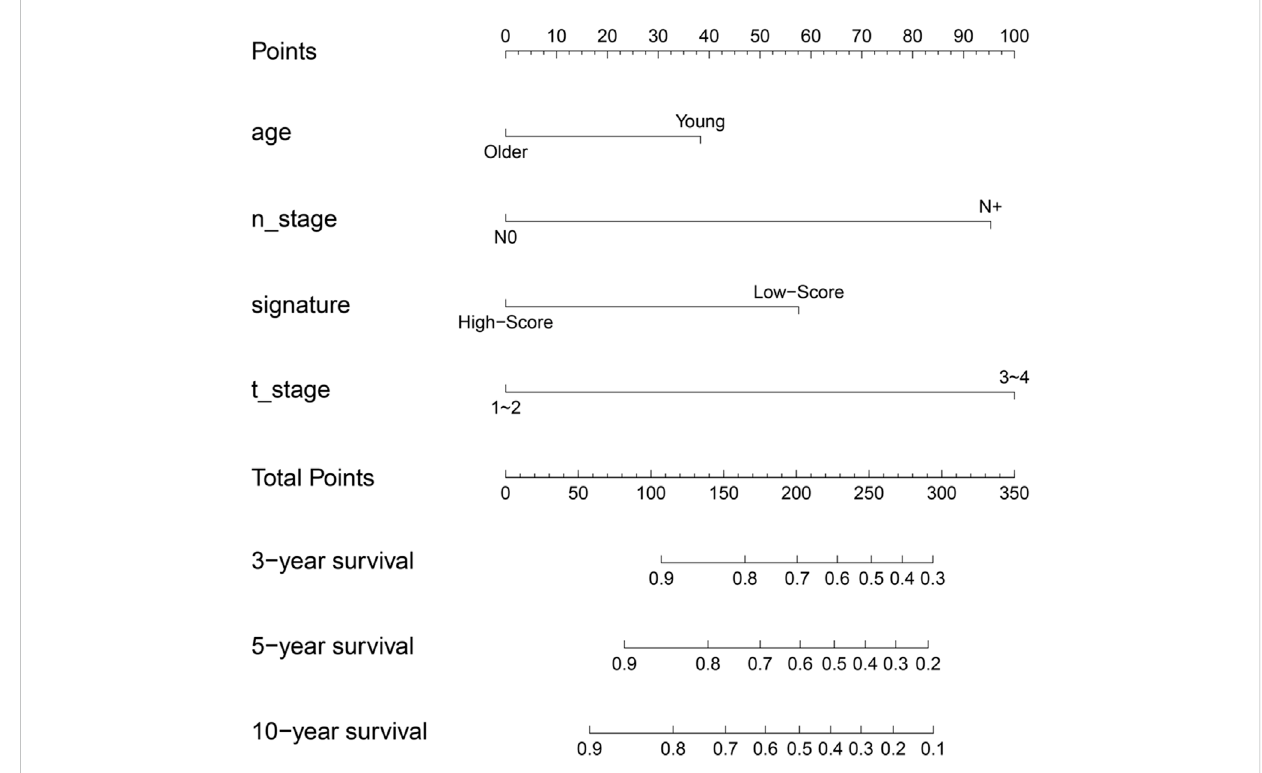
FIGURE 9 Nomogramto predictfor 3-year,5-year and10-yearprobabilitiesof DMFSfor breast cancer patients. Age: older: ≥ 60,young: < 60;T_stage:0:T0; 1: T1; 2: T2; 3: T3; 4: T4; N_stage: 0: N0; N+: N1, N2, N3; signature,